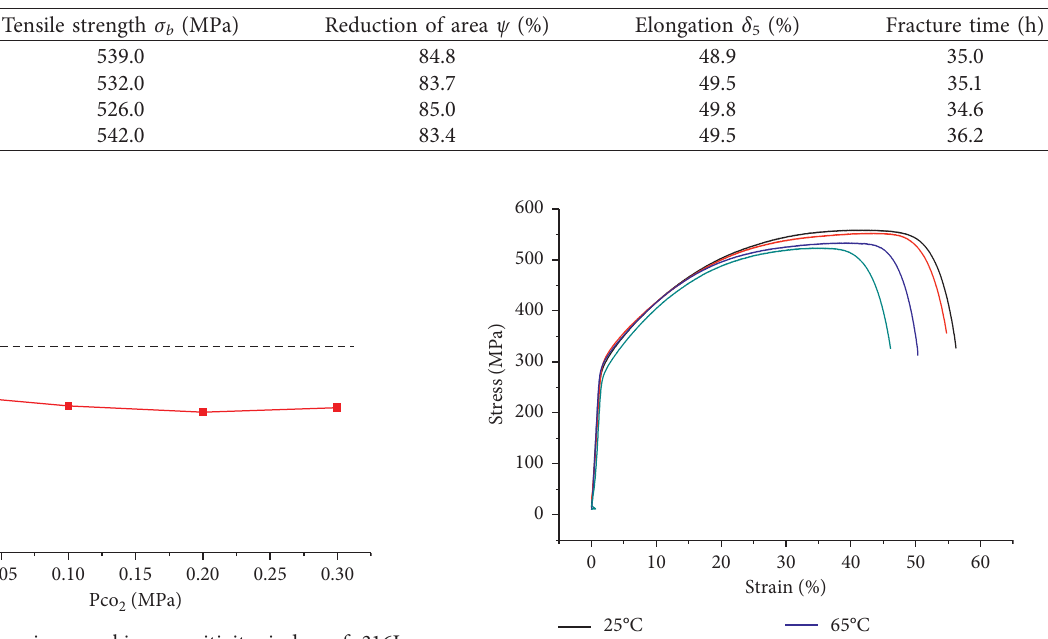
� 0.1MPa; 2 2 partial pressure.